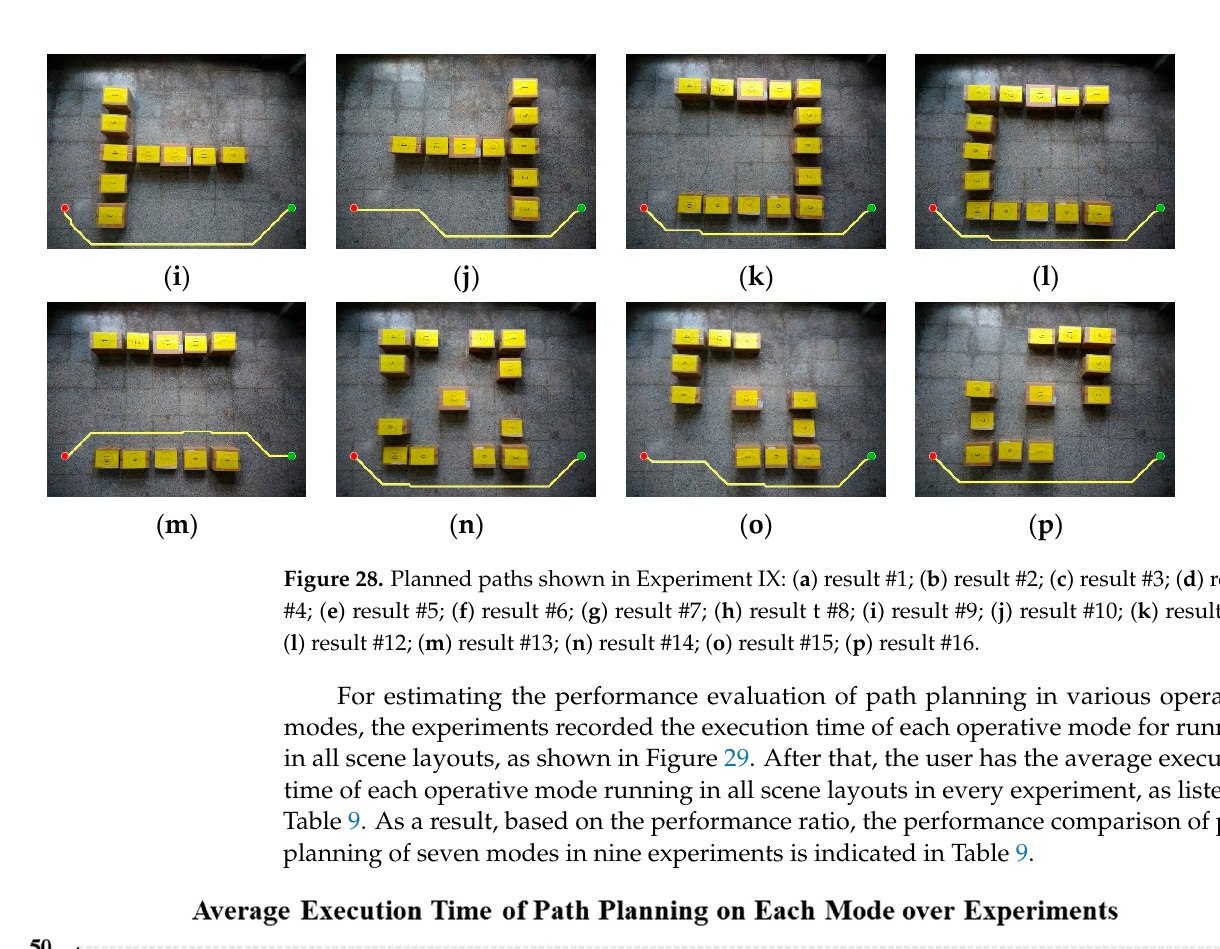
planning of seven modes in nine experiments is indicated in Table 9.